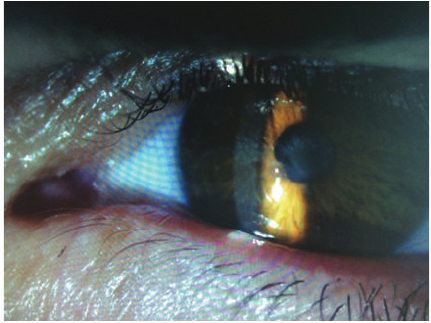
Figure 2: Slit lamp examination of the left eye.